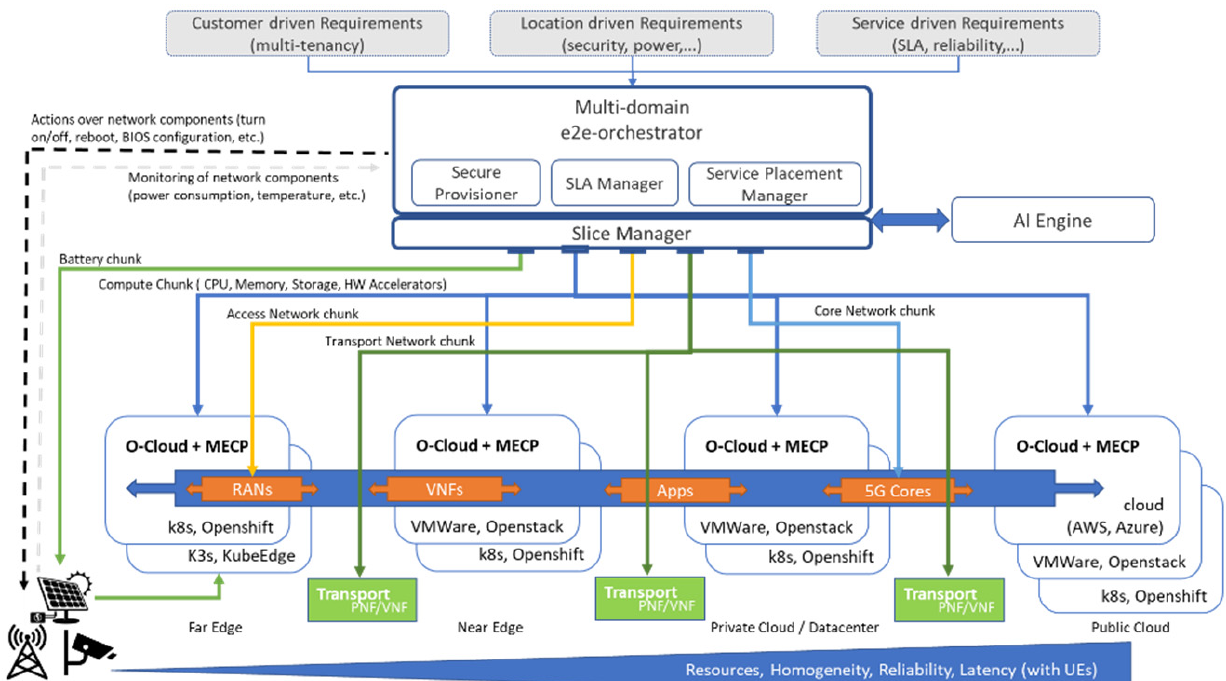
Figure 3. Orchestrator components.